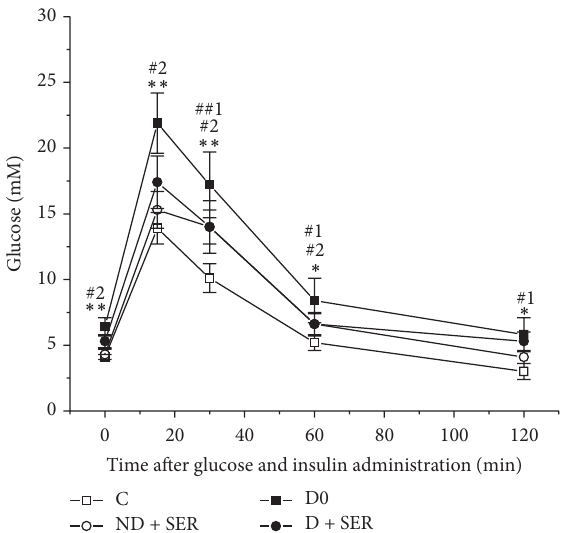
Figure 4: The concentration of plasma glucose in the course of insulin glucose tolerance test in diabetic and nondiabetic rats on the 140th day of experiment. 1—Group C0 ( 𝑛 = 6 ), 2—Group ND + SER ( 𝑛 = 8 ), 3—Group D0 ( 𝑛 = 10 ), and 4—Group D + SER ( 𝑛 = 8 ). The dataarepresentedasM ± SD.( ∗ , ∗∗ )ThedifferencebetweenGroups C0 and D0 and (#, ##) the difference between Groups C0 and ND + SER (1) or between Groups D0 and D + SER (2) are significant at 𝑃 < 0 . 05 and 𝑃 < 0 . 0001,